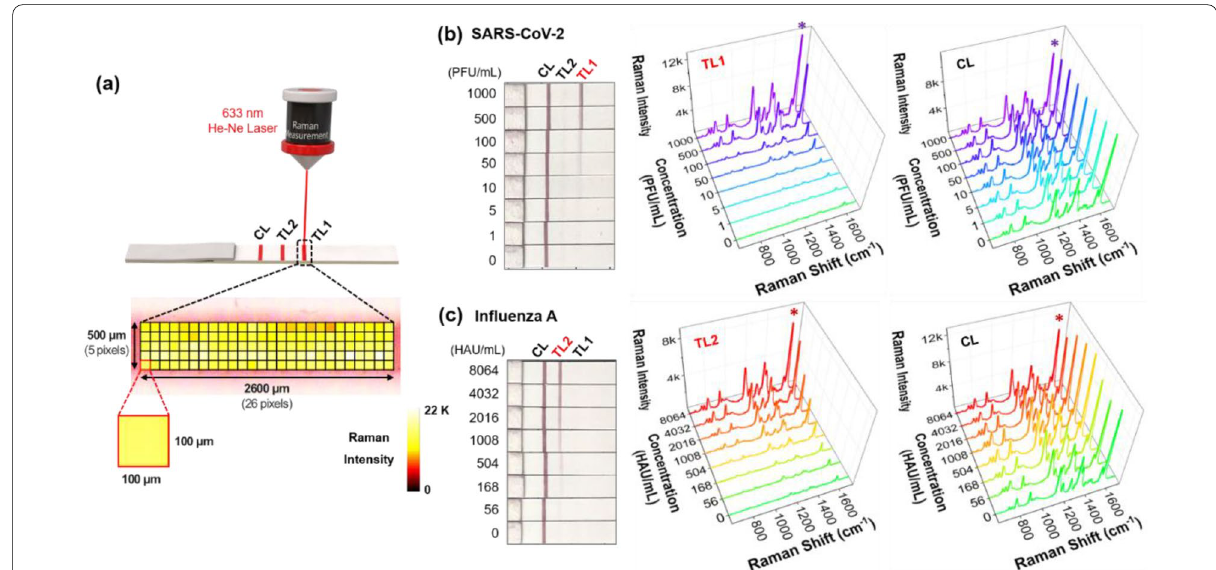
Fig. 3 a Pixel-to-pixel SERS detections for an area of 2600 μm 500 μm with a 100 μm interval for test and control lines. Raman signal intensities × for 130 spots were averaged to obtain reliable Raman signal intensity. b Visual color changes of the SERS-LFA strip and corresponding SERS spectra of the test and control lines when the concentration of SARS-CoV-2 lysate changed in the range of 0–1000 PFU/mL. c Visual color changes of the SERS-LFA strip and corresponding SERS spectra of the test and control lines when the concentration of influenza A virus lysate changed in the range of 0–8064